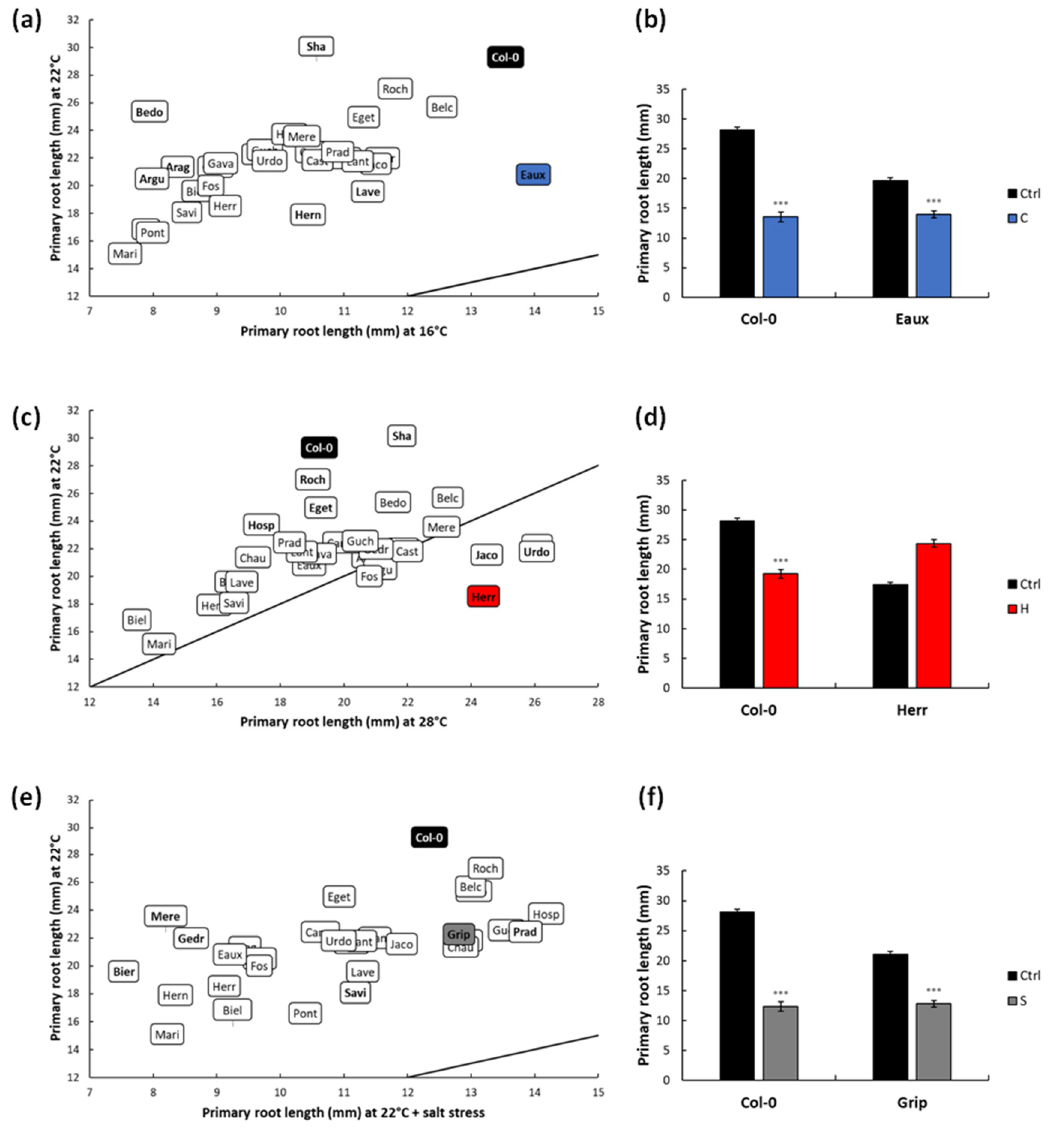
Figure 2. Scatter plot displaying the distribution of the populations according to their primary root lengths (PRLs) under ctrl and under ( a ) cold, ( c ) heat, and ( e ) salt stresses. The selected tolerant population under each successive treatment was highlighted blue, red, and grey, while Col-0 was highlighted in black. The line designates (y = x). Bar graphs displaying ( b ) the PRLs of Col-0 and Eaux under ctrl and cold conditions, ( d ) the PRLs of Col-0 and Herr under ctrl and heat conditions, and ( f ) the PRLs of Col-0 and Grip under ctrl and salt conditions. (***) signified the p -value < 0.0001 of the Student’s t -test of the pairwise comparisons between each treatment and the ctrl on the PRL of each population. The error bars represented the standard error of means